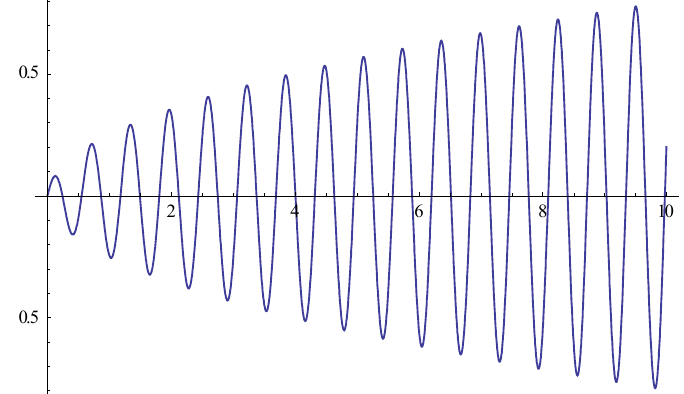
Figure A2. Plot for Eigen Values perpendicular to the cylinder radius using Equation (A2).